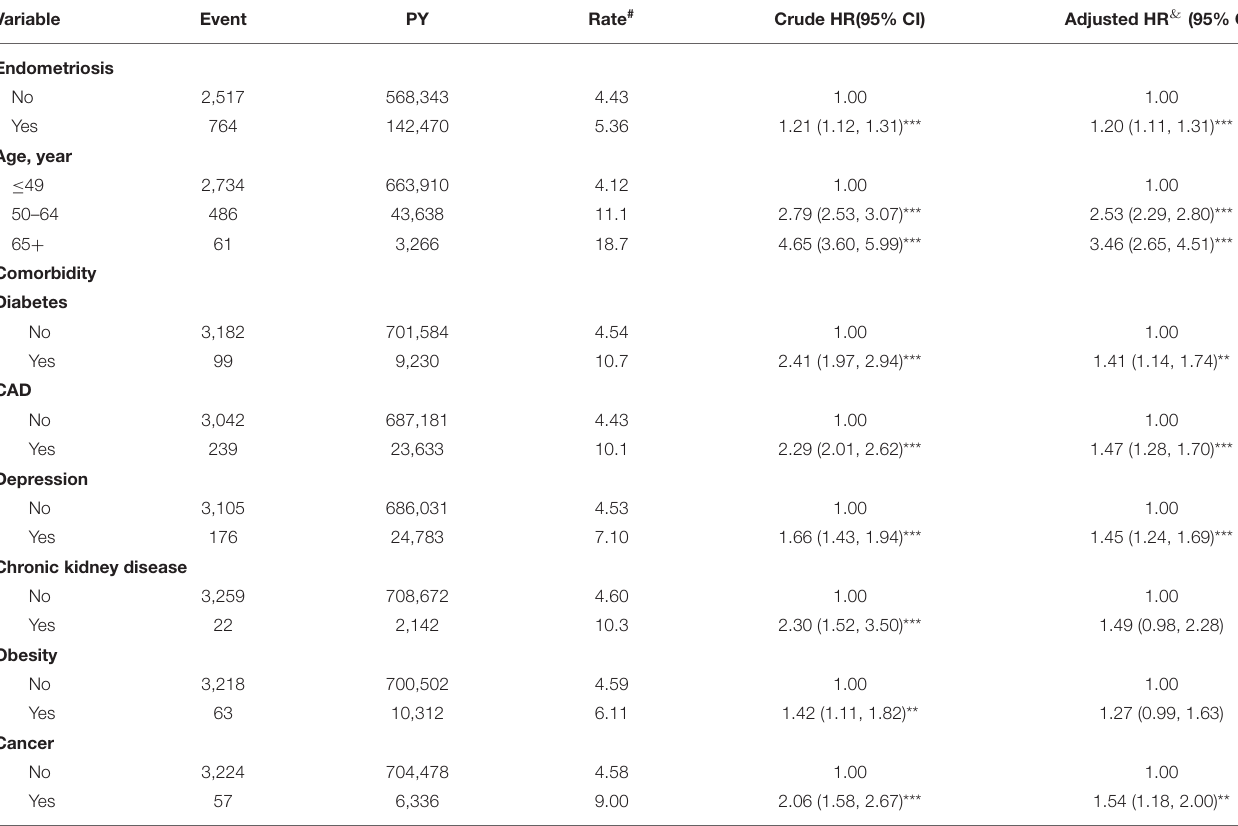
TABLE 2 | The incidence and risk factors for herpes zoster.